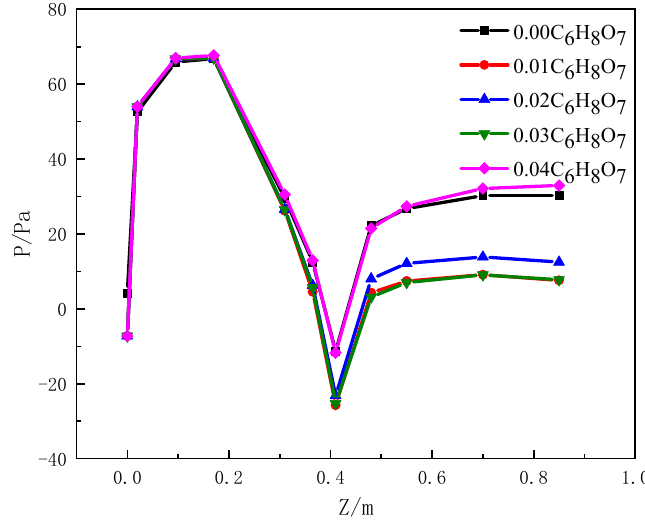
Figure 11. Reactor pressure curves with different citric acid ratios.